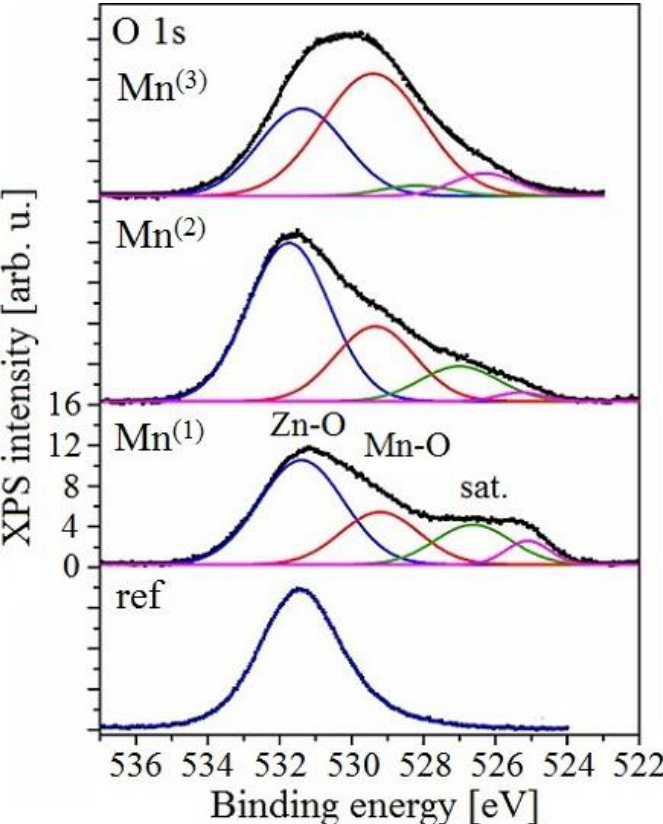
Figure 30. XPS spectrum of spectral region Mn 2p from all exposure — background subtracted from all spectra.